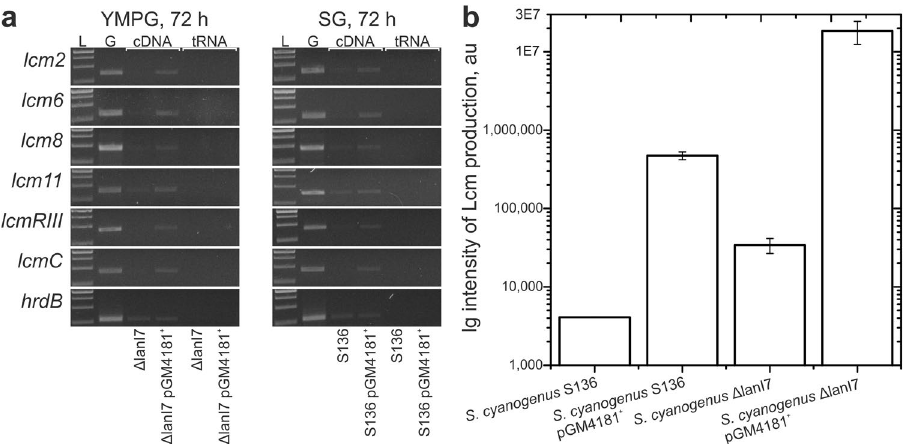
Figure 4. ( a ) Transcription of lcm genes involved in different stages of Lcm production (as well as house- keeping gene hrdB ) in S. cyanogenus ΔlanI7 and ΔlanI7 pGM4181 + grown in YMPG medium for 72 h; S. cyanogenus S136 and S136 pGM4181 + grown in landomycin production SG medium. Genomic DNA isolated from S136 strain served as a positive control for the PCR-reactions (G). Total RNA samples from ΔlanI7, ΔlanI7 pGM4181 + , S136 and S136 pGM4181 + were negative controls of the PCR reactions; (L) was 1 kbp DNA Ladder (Thermo Fisher Scientific, USA). ( b ) Quantification of Lcm production by S. cyanogenus S136, S136 pGM4181 + , ΔlanI7 and ΔlanI7 pGM4181 + grown in YMPG for 120 h. Areas of Lcm mass peaks (708.35 Da (M + H) + ) were integrated and represented as arbitrary units (au); please note logarithmic scale of the y -axis. Data represent mean values of three independent experiments ±